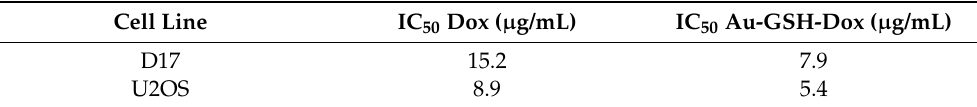
Figure 1. Correlation between the logarithm of Dox (red line) and Au-GSH-Dox (black line) doses and cell viability (measured by MTT assay) for D17 ( A ) and U2OS ( B ) cell lines. Table 1. Half-maximal inhibitory concentration (IC 50 ) of Dox and Au-GSH-Dox for the D17 and U2OS cell lines.